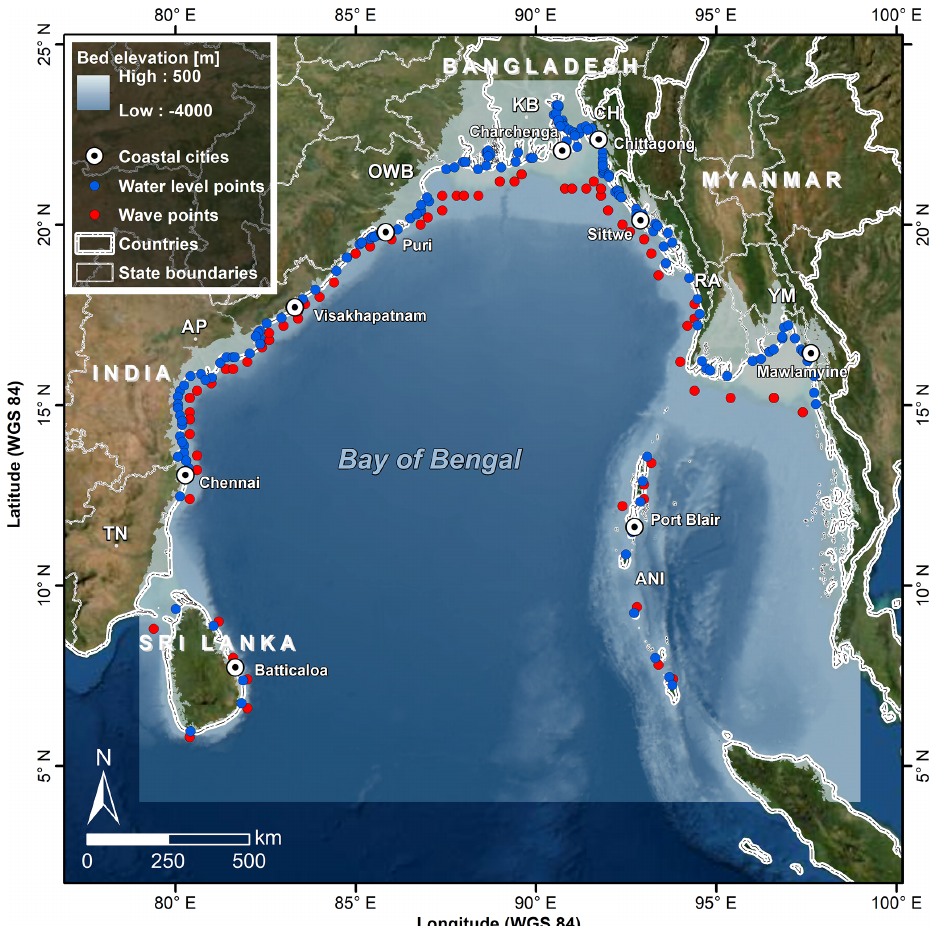
Figure 1. Map of the Bay of Bengal with satellite image (Esri) and bed elevation (GEBCO; Becker et al., 2009) including locations of output points for detailed analysis at different coastal cities along the bay (white circles with dot), water levels (blue dots) and waves (red dots). Country and state boundaries are indicated in white lines (Esri). For a summary of countries, regions (with abbreviations used) and locations for further detailed analysis, see Table